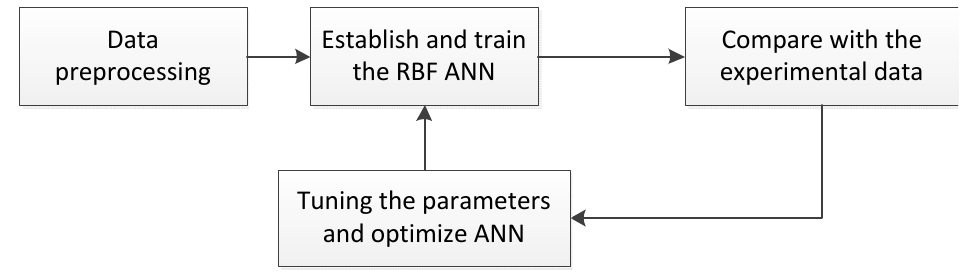
Figure 2. Procedure of developing a well-trained ANN.